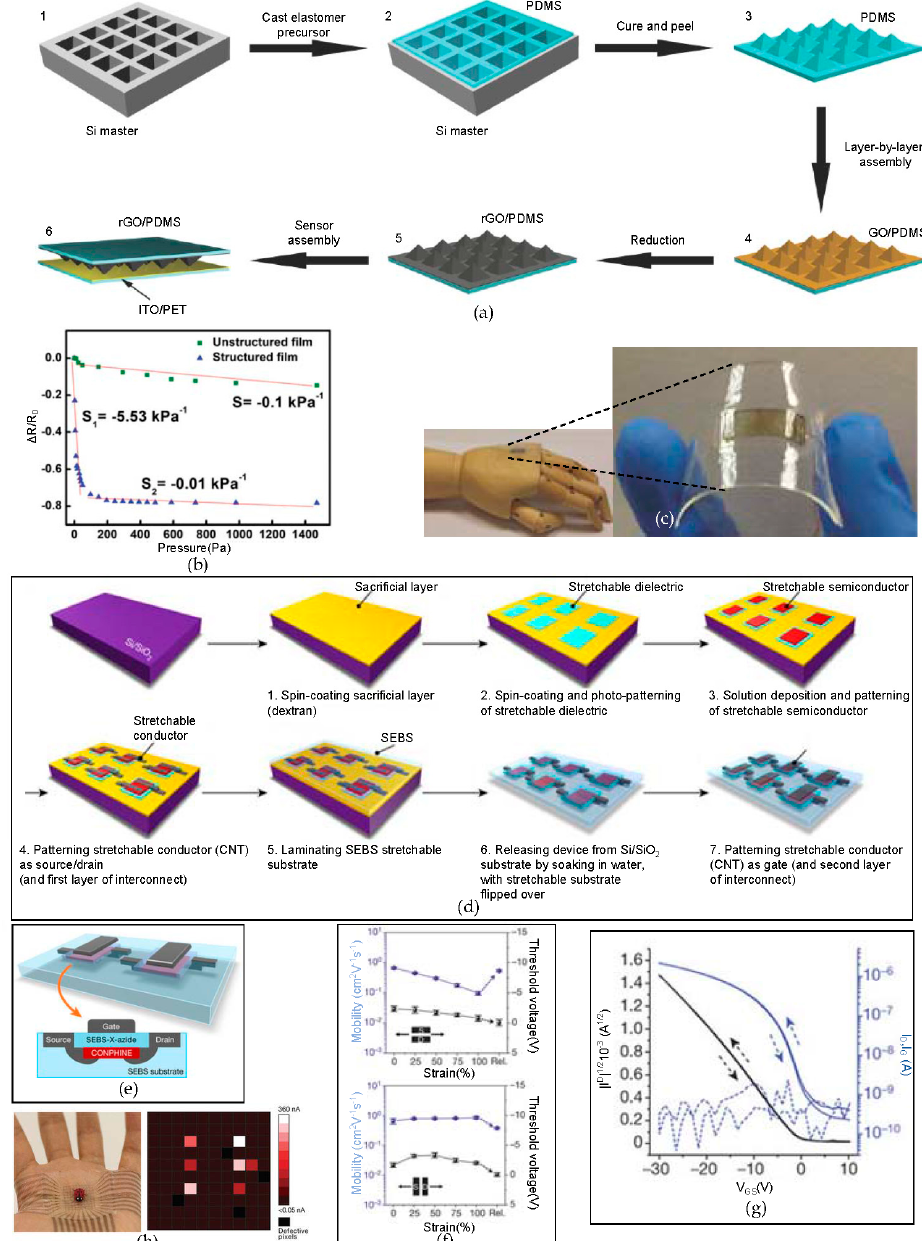
Figure 8. Microstructured graphene arrays for sensitive flexible tactile sensors/electronic skin based on a stretchable transistor array. ( a ) A schematic of the fabrication of a flexible tactile sensor device via the layer-by-layer (LBL) assembly method. An ultrathin graphene film that detects applied pressure is deposited on the PDMS film; ( b ) the pressure response curves of unstructured and structured rGO/PDMS films. The slope of the relative resistance change is − 5.53 kPa − 1 at 100 Pa, which shows very sensitive changes at lower pressures; ( c ) an image of the tactile senor applied on the flexible substrate. Reproduced with permission from 2014 Small [88]. ( d ) a schematic of the fabrication process for arrays of flexible transistors; ( e ) a magnified view of a flexible transistor exhibiting high performance; ( f ) the mobility and threshold voltage changes when applying strain from 0% to 100%; ( g ) the I–V characteristics of fabricated transistors, which have almost no hysteresis; ( h ) stretchable arrays of transistors attached to the human palm with a small artificial lady bug with six legs and the corresponding result from the stretchable sensor. Reproduced with permission from 2018 Nature [97].